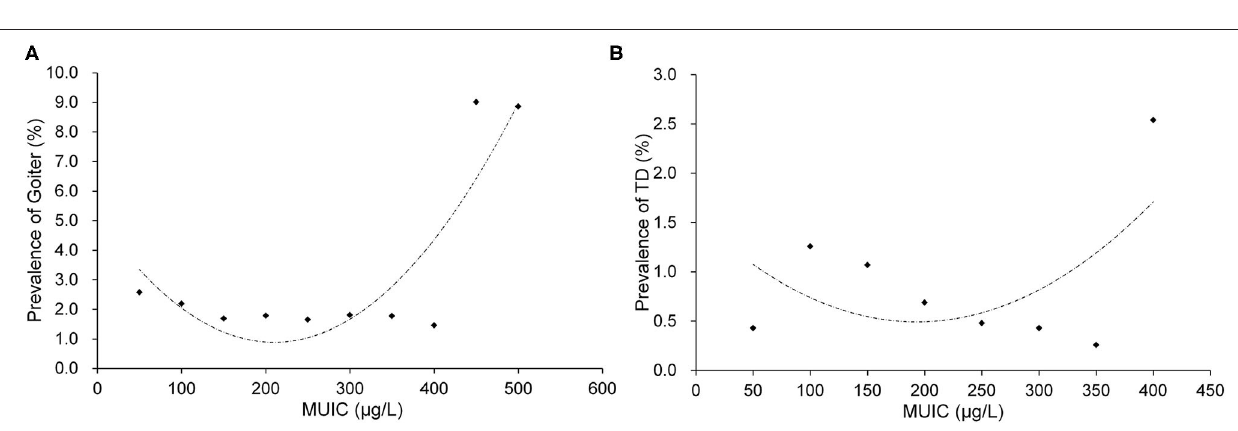
Figure 2 presents the relationships of MUIC with goiter in children ( Figure 2A ) and thyroid disease in pregnant women ( Figure 2B ). MUIC was divided into 10 groups ( < 100 µ g/l, groups with an interval of 50 and ≥ 500 µ g/l) in Figure 2A and 8 groups ( < 100 µ g/l, groups with an interval of 50 and ≥ 400 µ g/l) in Figure 2B . The prevalence rates of goiter in children